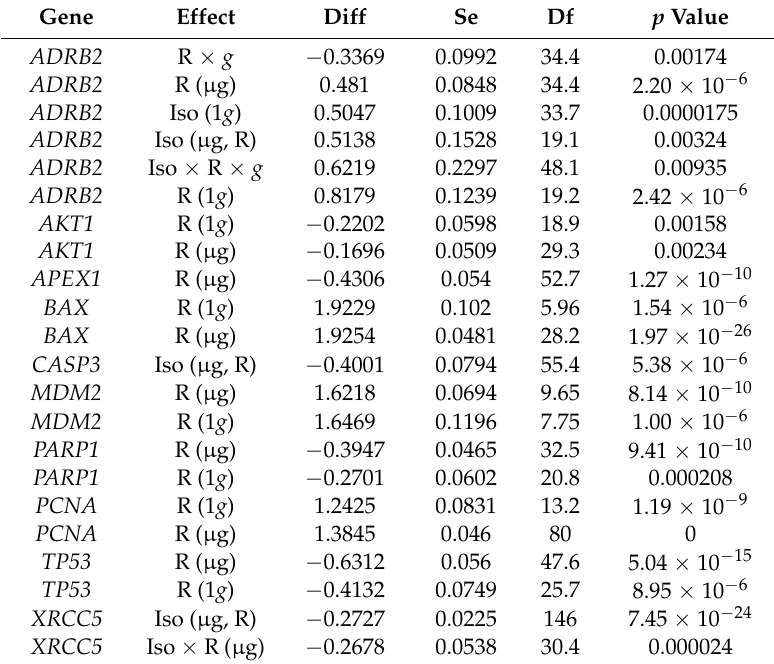
Table 3. Significant differences in mean transformed gene expression (2 Gy). Effects listed below are described in Table